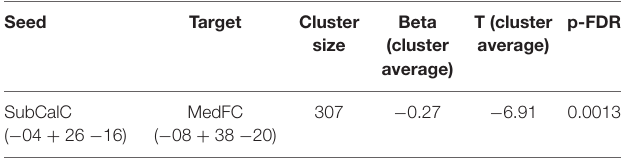
TABLE 3 | Seed-to-voxel whole-brain analysis using the subcallosal cortex as a